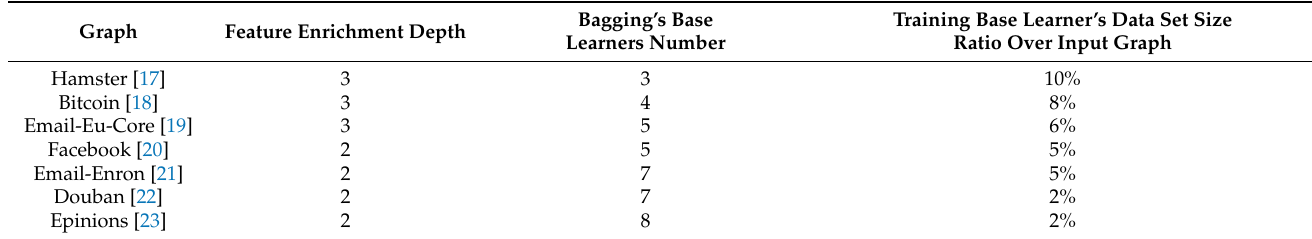
Table 4. The bagging ensemble learner’s execution parameters per distinct social graph of the distributed stacking ensemble community prediction methodology.